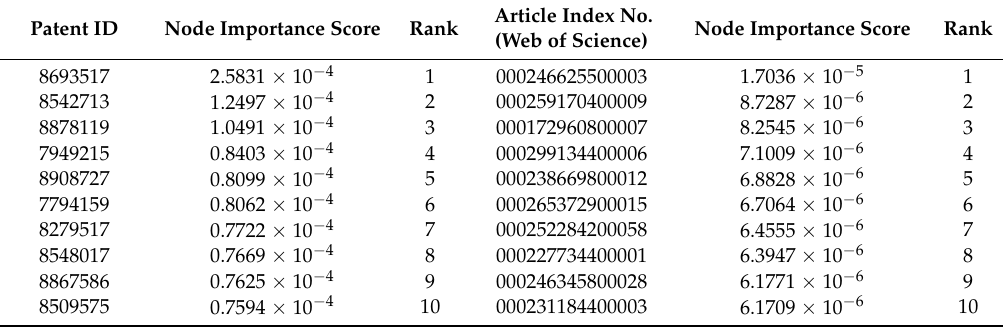
Table 4. Assessment results of node importance in the dual-layer knowledge-flow network.